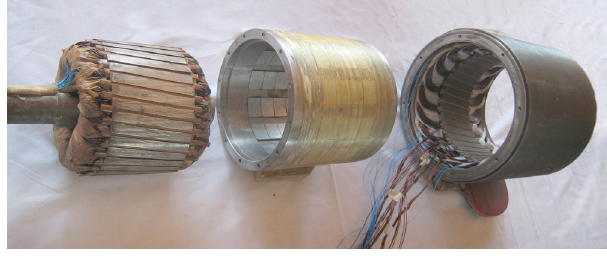
Figure 6. Main components of the manufactured CS-PMSM prototype machine: the inner rotor (left), the outer rotor with permanent magnets on both sides (middle), and the stator with housing (right).